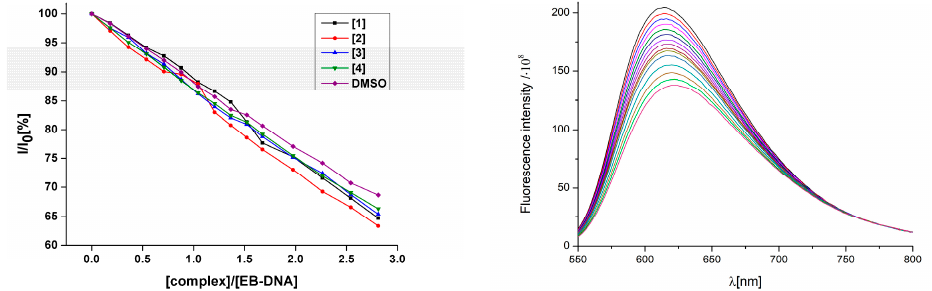
Figure 11. Graphical dependence of relative EB-DNA fluorescence emission intensity (I/I 0 ) at 615 nm vs. concentration ratio [complex]/DNA for 1 – 4 . Fluorescence emission spectra for EB-DNA in the buffer solution in the presence of increasing amounts of 4 . Table 7. EB-DNA fluorescence (%), calculated Stern–Volmer constant K SV and the quenching rate constant k q of DMSO and complexes 1–4 .